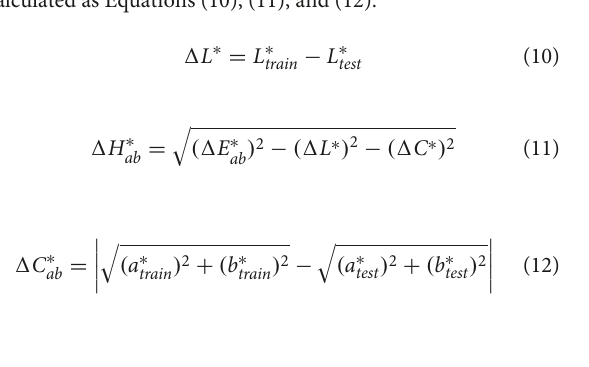
in this type of methods; and the chromaticity vector angle apparently has the same problem of being unable to characterize and measure the color perception features, which is still not accurate enough. Therefore, this study proposes to use three color perception feature measures of CIELAB uniform color space for sample color difference. In the CIELAB uniform color space, we assume that the color values of the training and , a ∗ , b ∗ ) and ( L ∗ test samples are ( L ∗ , , a ∗ , b ∗ ), then test test test trian trian trian the color difference (cid:49) E ∗ between them can be calculated by ab Euclidean distance in the color space, as in Equation (8)